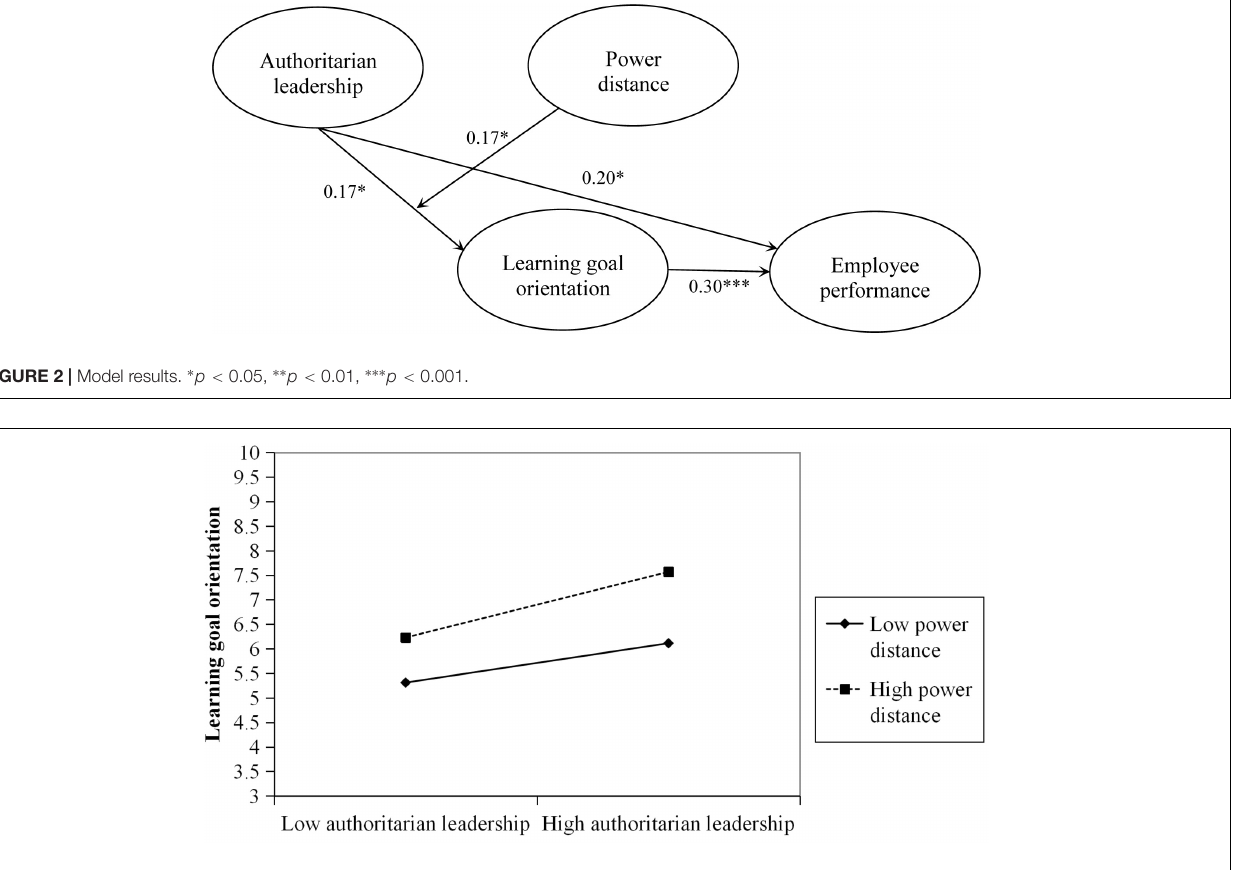
FIGURE 3 | Interaction between authoritarian leadership and power distance on learning goal